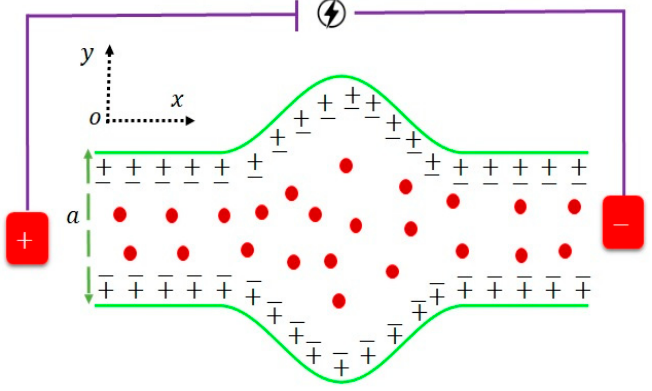
Figure 1. Convergent geometry.